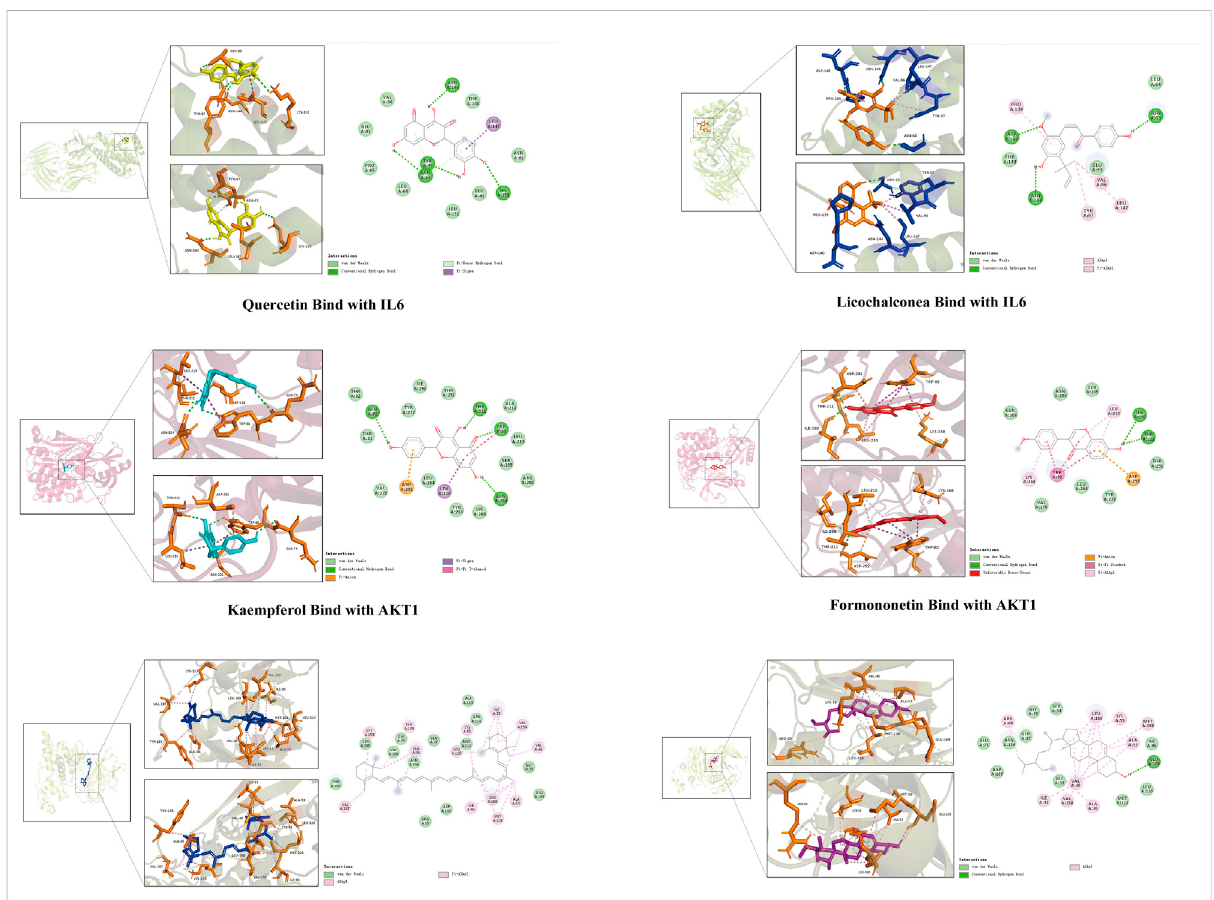
FIGURE 6 Interaction between key components of HQJZD and core target proteins. The six fi gures exhibit the quercetin and licochalconea binding with IL-6; kaempferol and formononetin binding with AKT1; and β -carotene and β -sitosterol binding with